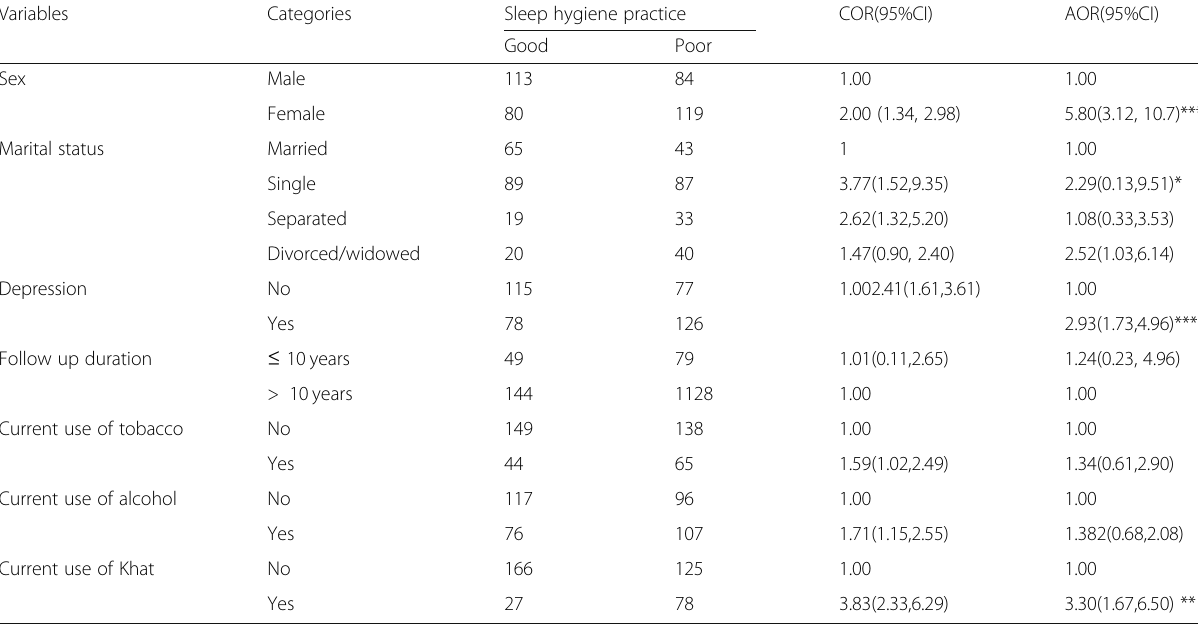
Table 3 Bivariable and multivariable analysis of factors associated with poor sleep hygiene practice among people with HIV/AIDS attending ART follow-up at Zewditu Memorial Hospital, Addis Ababa, Ethiopia, 2018 ( n = 396)